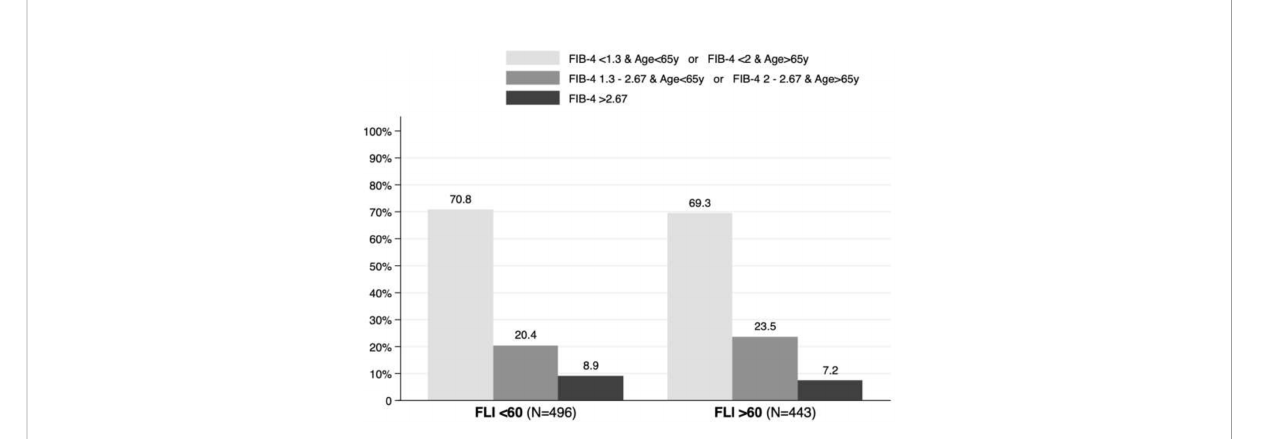
FIGURE 4 Fibrosis-4 (FIB-4) adjusted by age in patients with and without non-alcoholic fatty liver